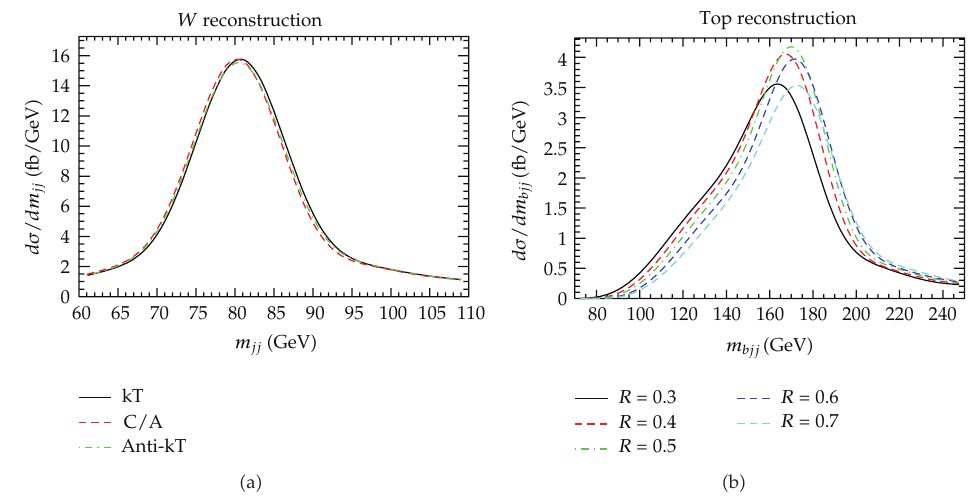
Figure 7: Mass reconstruction of the hadronically decaying W (cid:2) a (cid:3) and t -quark (cid:2) b (cid:3) for the signal with m h ± (cid:7) 130GeV when R (cid:7) 0 . 5 (cid:2) a (cid:3) and using the anti-kT algorithm (cid:2) b (cid:3)